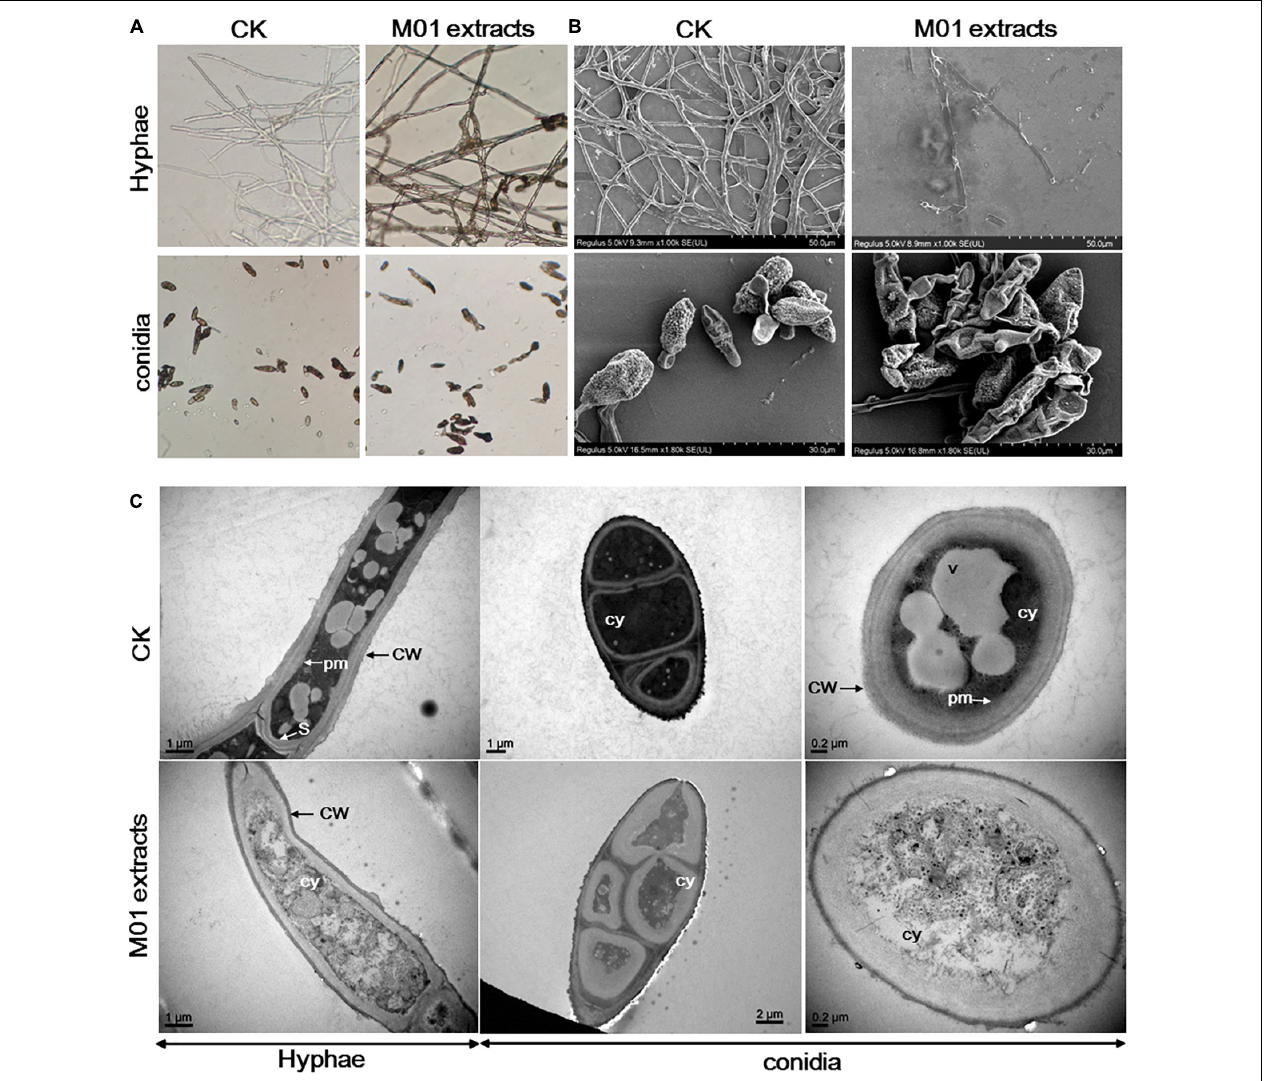
FIGURE 1 | Effect of Streptomyces lydicus M01 extracts on the morphology of Alternaria alternata hyphae and conidia. (A) Effect of M01 extracts on the morphology of A. alternata hyphae and conidia observed with a light microscope. Ultrastructural effects of S. lydicus M01 extracts on A. alternata determined by scanning electron microscopy (B) and transmission electron microscopy (C) . CW, cell wall; pm, plasma membrane; S, septum; cy, cytoplasm. In control experiments (CK), A. alternata hyphae and conidia was treated with